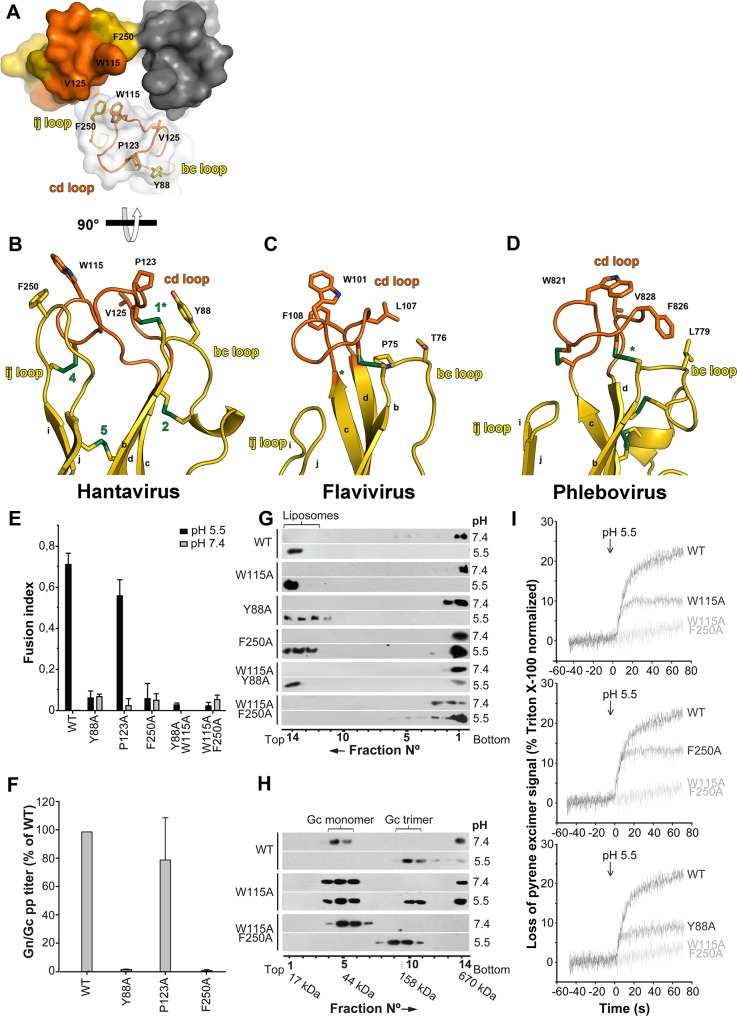
The Gc fusion loops.A) Surface representation of the tip of HNTV domain II viewed down the three-fold axis from the membrane. Two of the subunits are shown in solid surface representation and the third was rendered semi-transparent to visualize the polypeptide chain and selected side chains. B) Orthogonal view of one protomer, with the same residues and loops labeled. C) For comparison, the same representation of flavivirus E (Dengue 2, 1OK8; [53]) and D) phlebovirus Gc (RVFV, 4HJ1; [20]) fusion loop region. Note that in hantavirus Gc, the ij loop is longer and projects Phe250 to the membrane, whereas in flaviviruses and phleboviruses, it is not the case (the same holds true for alphaviruses, not depicted here). Similarly, the bc loop projects Tyr88 towards the membrane. E) Fusion activity of cells expressing Andes virus wild type Gn and wild type or mutant Gc at neutral or acid pH. Syncytia formation was quantified by counting cells and nuclei using three-color fluorescence microscopy (S6 Fig) and results from at least n = 2 experiments were averaged. F) Entry into Vero E6 cells viral particles pseudotyped with Andes virus spikes with wild type Gn and wild type or indicated mutant Gc (Gn/Gc pp; as in Figs 3D and 4E; see the S7 Fig for cell cytometry quantification of reporter GFP production). G) Liposome co-flotation assay to visualize acid-induced membrane interaction of wild type and mutant Andes virus VLPs. VLPs were incubated with liposomes labeled with a fluorescent dye (DPH, see Materials and Methods) at pH 7.4 or 5.5. Fractions of the step gradient sedimentation were examined for the presence of Gc by western blot and liposomes by fluorescence. H) Trimer formation by wild type and mutant Gc. Sucrose sedimentation of VLPs incubated at pH 7.4 or 5.5 and detection of Gc by western blot analysis. I) Acid-induced lipid mixing kinetics with liposomes of VLPs including Gn and wild type or mutant Gc. The decrease of pyrene-excimer fluorescence intensity was detected upon low pH incubation of pyrene-labeled VLPs with liposomes as a function of time. Results are representative for at least n = 2 independent experiments.